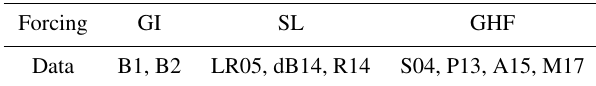
Table 1. Available choices of selected forcing fields for the model ensemble. B1 and B2 stand for the two glacial indices derived from Michel et al. (2016) and Snyder (2016); SL data from Lisiecki and Raymo (2005) (LR05), de Boer et al. (2014) (dB14) and Rohling et al. (2014) (R14); and GHF data from Shapiro and Ritzwoller (2004) (S04), Purucker (2013) (P13), An et al. (2015) (A15) and Martos et al. (2017) (M17). Forcing GI SL GHF Data B1, B2 S04, P13, A15,